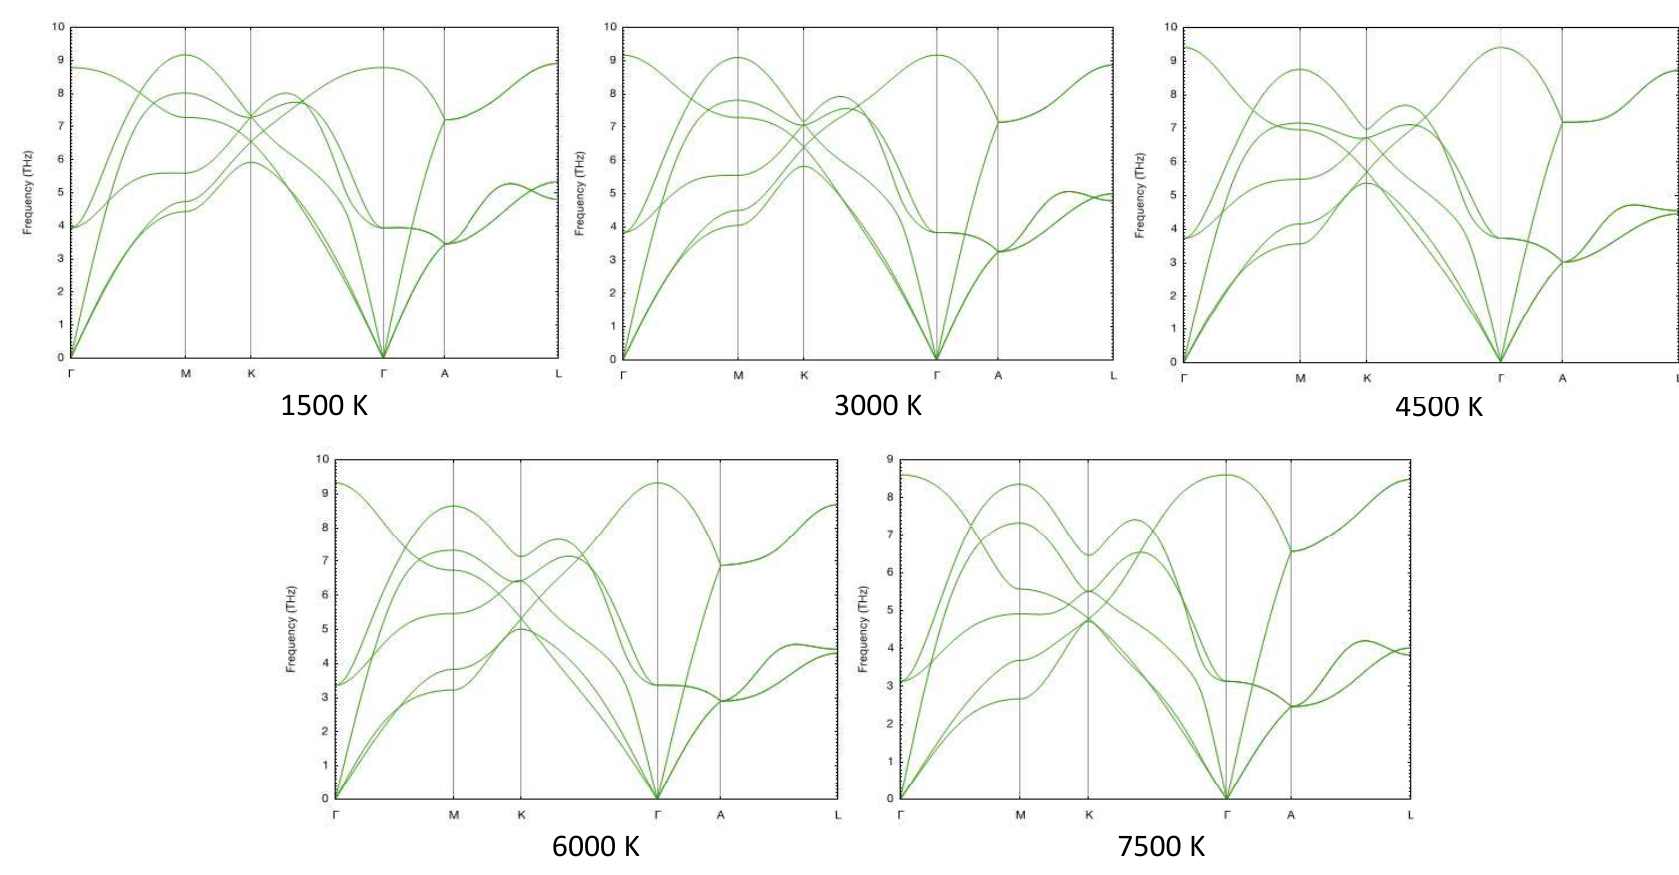
Figure 12. Phonon spectra of hcp-Re as functions of T at a fixed density of 25.1 g/cc.